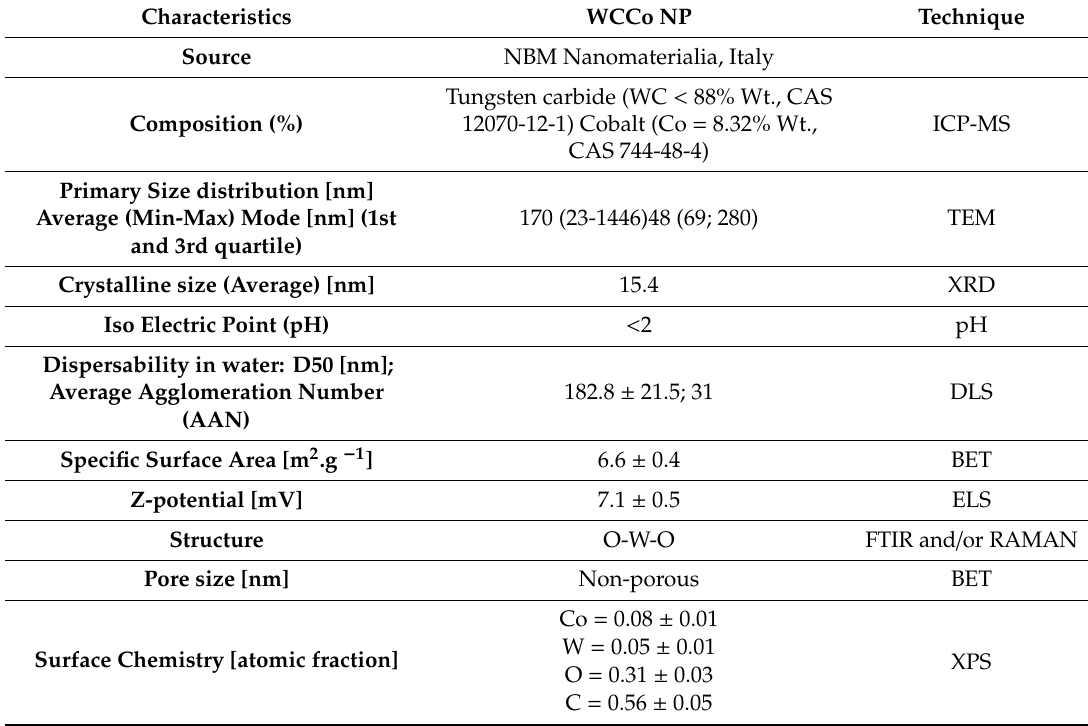
Table 1. Characterization of tungsten carbide cobalt nanoparticles (WCCo NPs) (FP7 SUN: